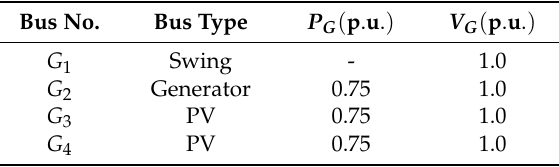
Table A3. Generator Data of Test System.